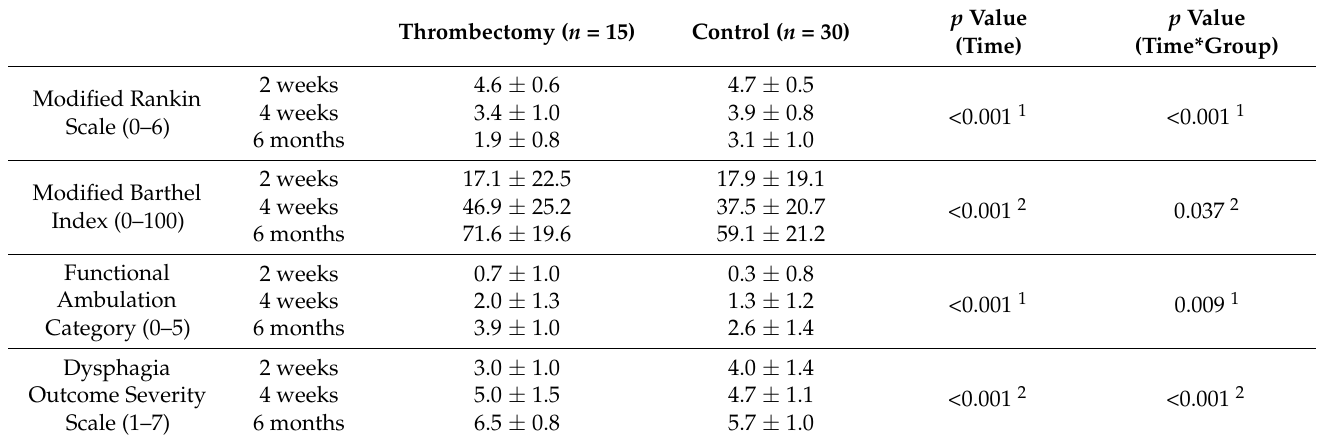
Table 2. Functional recovery with time and thrombectomy.